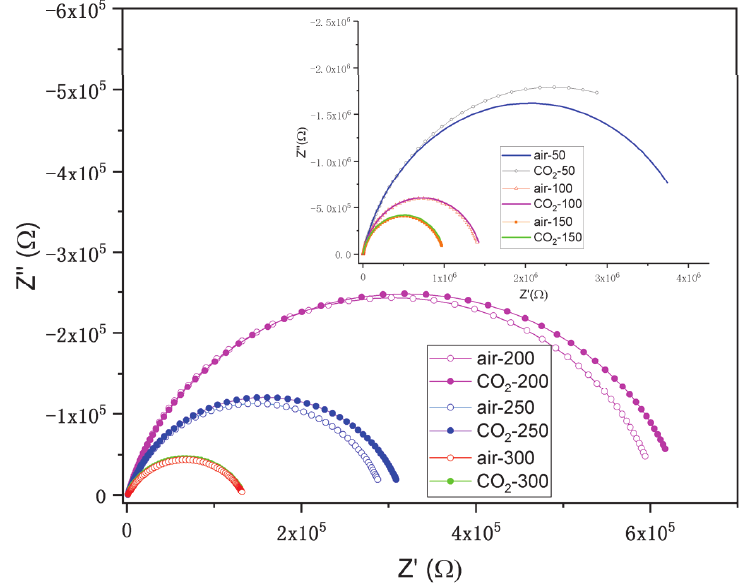
Figure 10. Nyquist representation of the impedance plots of the ITO/Si film in air and in CO 2 (1000 ppm in air) at different temperatures (100–300 °C).